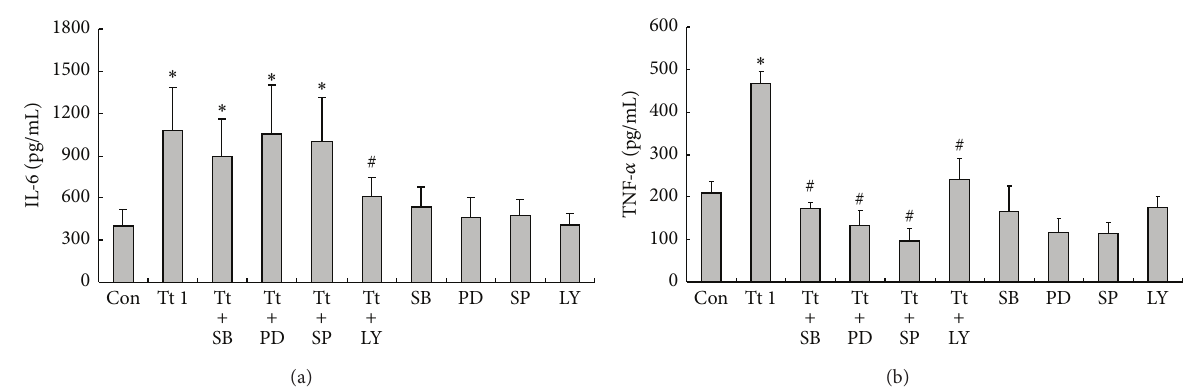
Figure 4: Effects of inhibitors of cell signaling pathways on tryptase (Tt)-induced secretion of IL-6 (a) and TNF- 𝛼 (b) from astrocytes. Astrocytes were exposed to 1 𝜇 g/mL of tryptase in the presence or absence of SB203580 (SB, 20 𝜇 M), PD98059 (PD, 20 𝜇 M), SP600125 (SP, 20 𝜇 M), and LY294002 (LY, 20 𝜇 M) at 37 ∘ C for 24 h before culture supernatant being collected. Data are presented as the mean ± SEM of four independent experiments. ∗ 𝑃 < 0.05 versus control groups (Con), # 𝑃 < 0.05 versus corresponding tryptase treatment